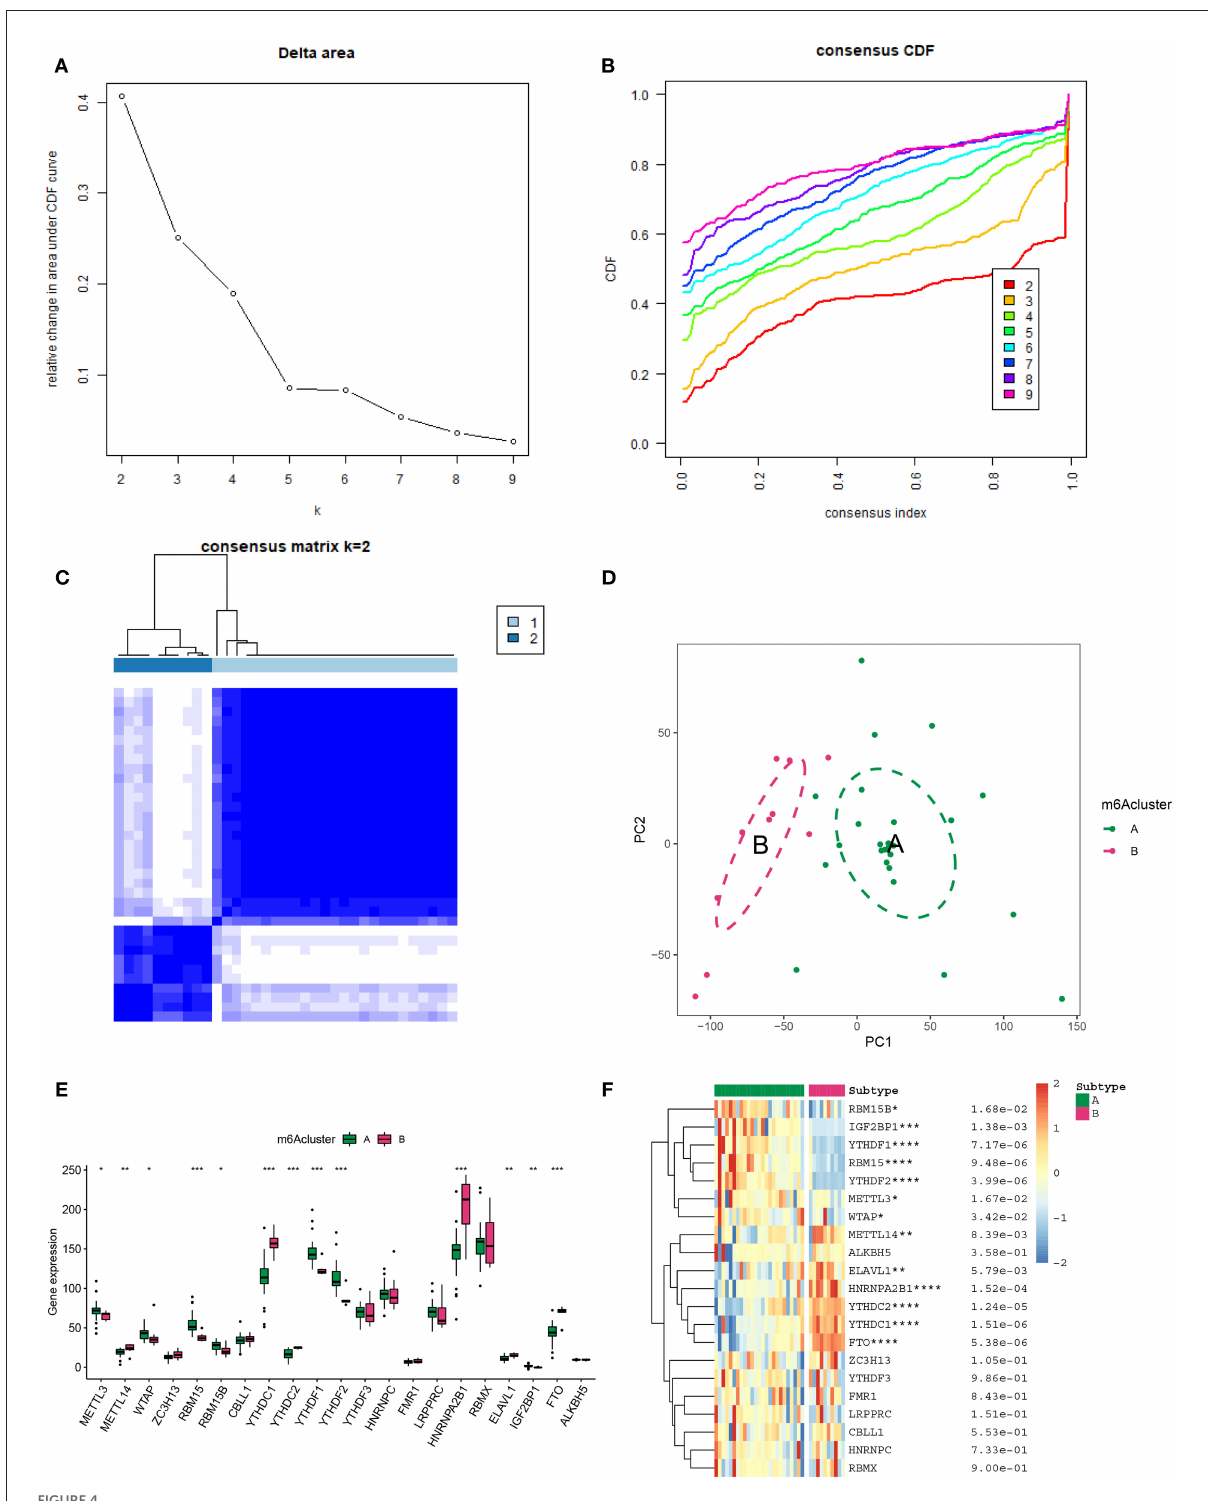
FIGURE4 Unsupervised clustering of 21 m6A genes in AD samples. (A) Relative alterations in the area under the cumulative distribution function (CDF) curve for k = 2-9. (B) Consensus clustering CDF for k = 2-9. (C) Heatmap of the co-occurrence ratio matrix of AD samples. (D) Principal component analysis of the transcriptome profiles of the 2 m6A clusters revealed significant differences in the transcriptomes of different m6A modification patterns. (E) The expression level of 21 m6A genes in two m6A AD clusters. (F) Unsupervised classifying of 21 m6A genes in two m6A AD clusters. * p < 0.05, ** p < 0.01, *** p < 0.001 indicated the statistical significance of